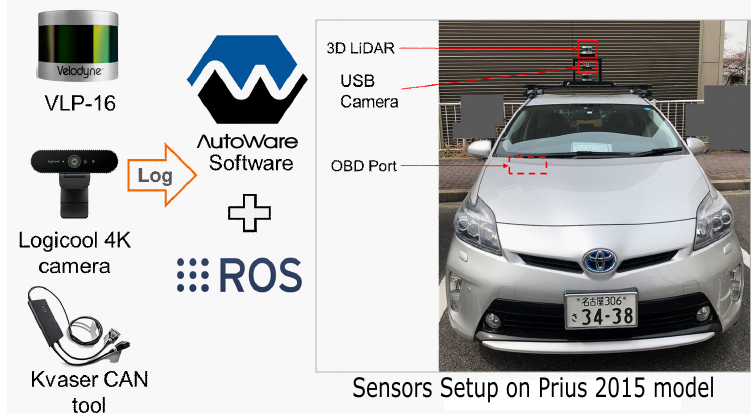
Figure 4. Sensor setup for collecting the real-road driving